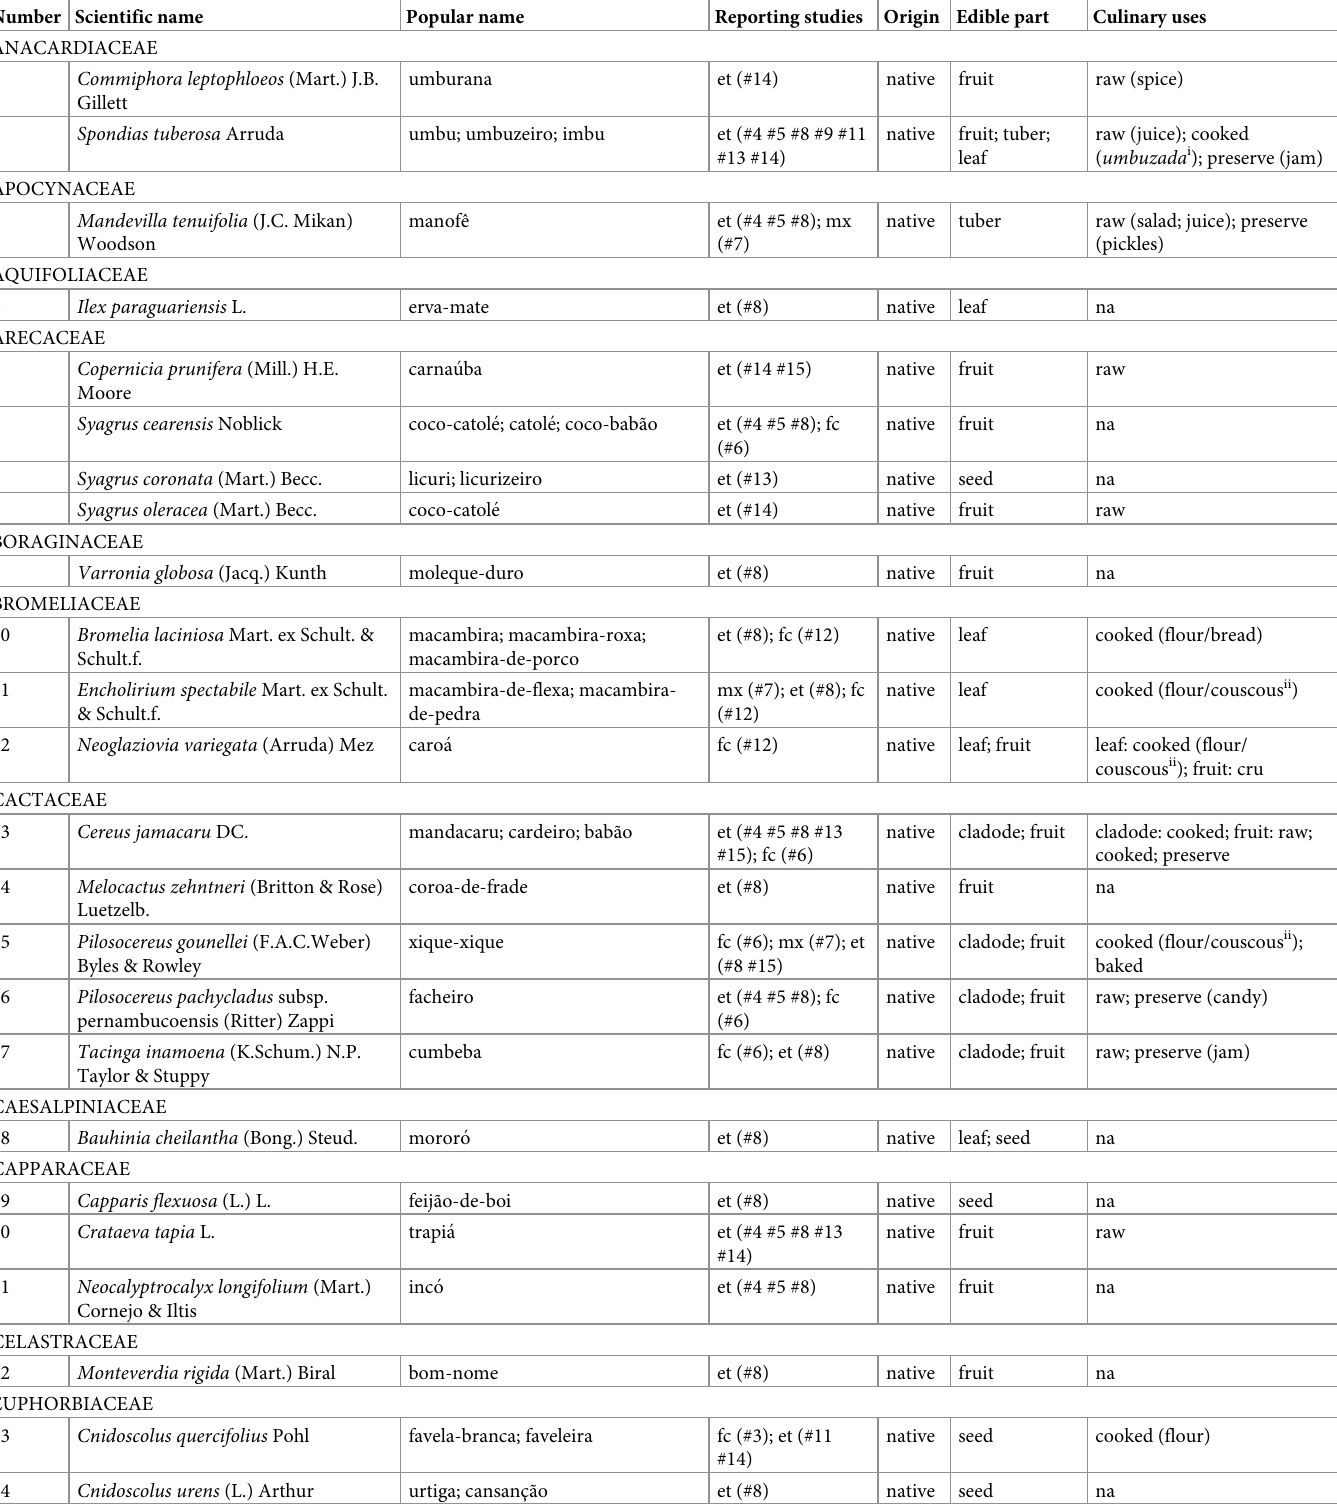
Table 2. Synthesis of food plants and potentially edible plants occurring in the